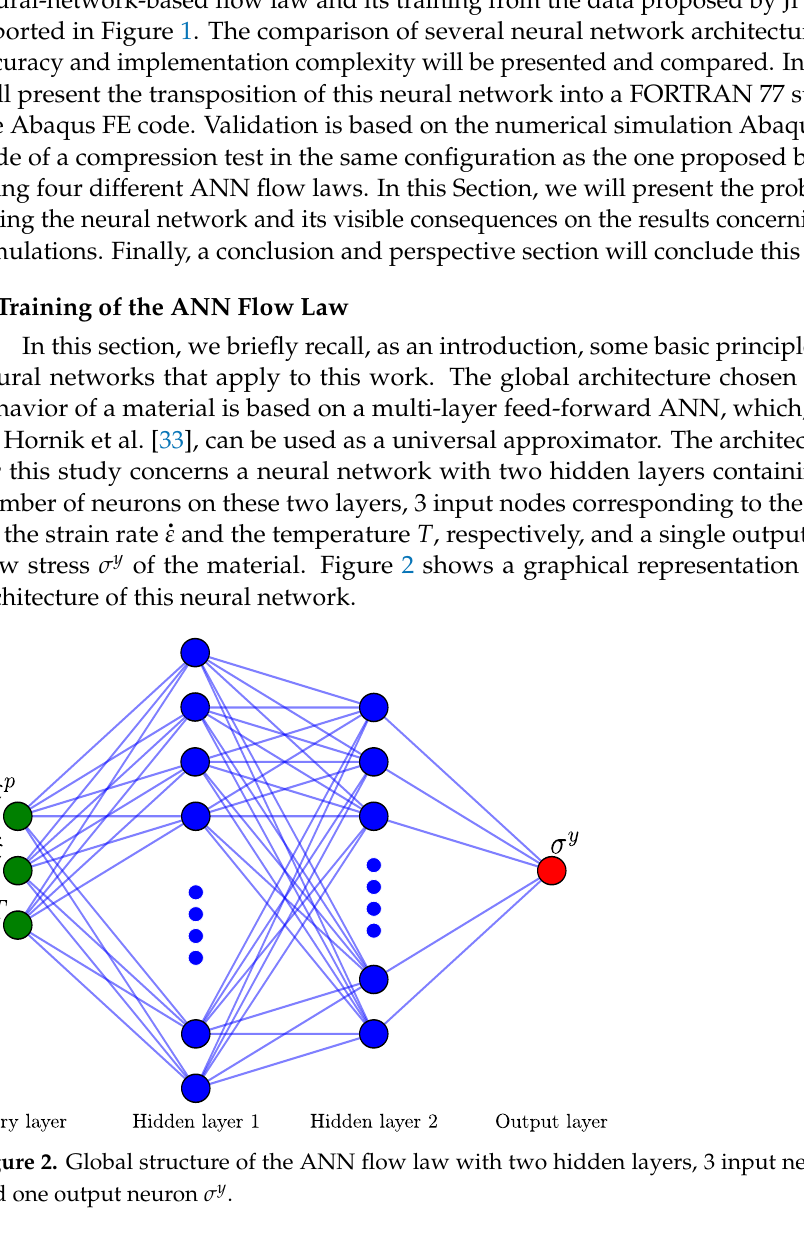
Figure 2. Global structure of the ANN flow law with two hidden layers, 3 input neurons ( ε p , and one output neuron σ y